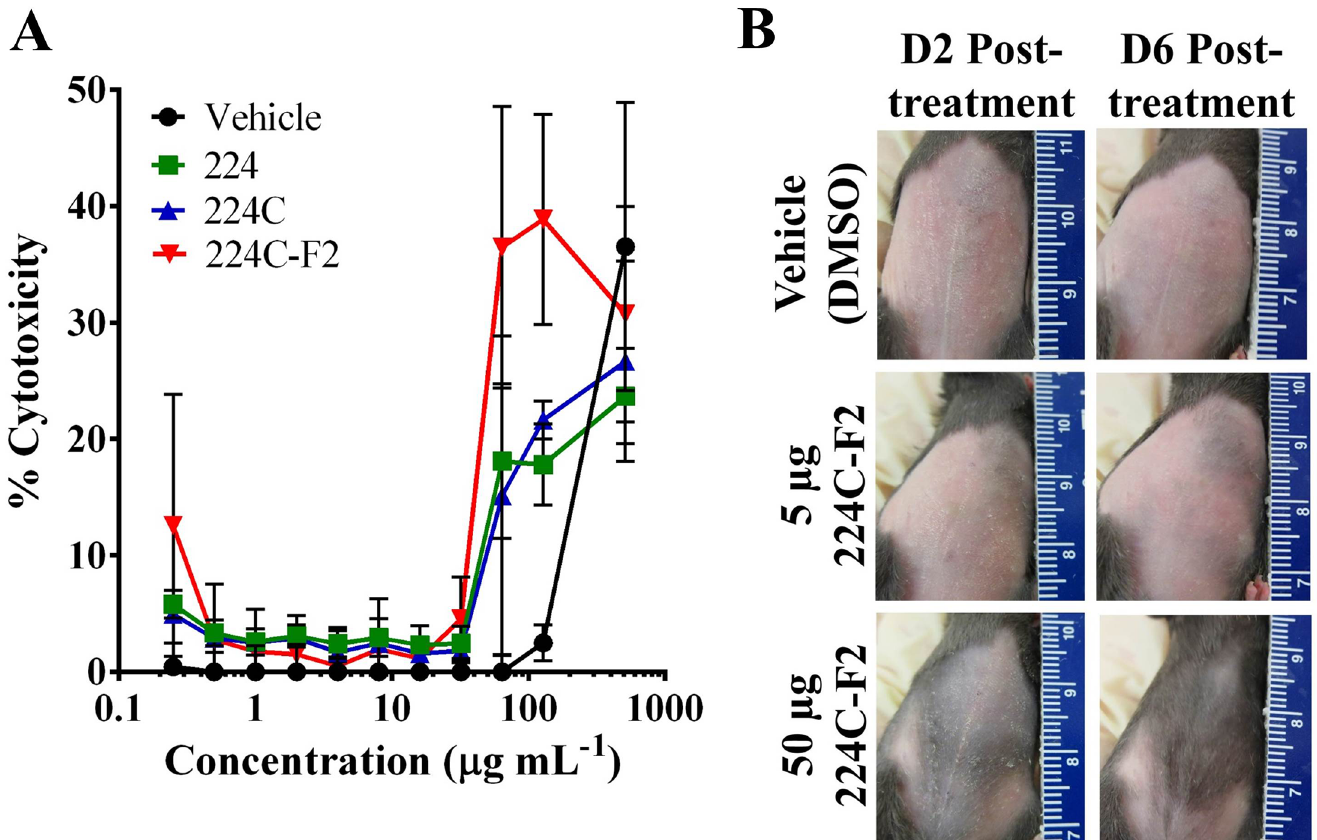
Fig 7. 224C-F2 is non-toxic to human keratinocytes and murine skin. (A) Immortalized human keratinocytes (HaCaT cells) were treated with up to 512 μ g mL -1 of extract fractions (24 hrs). The LD 50 for 224C-F2 could not be determined at this test range, indicating that it is well above the active dose for quorum quenching activity (IC 50 = 1.56 – 25 μ g mL -1 , depending on strain). (B) Uninfected mice received an intradermal injection of 5 or 50 μ g 224C-F2. No gross alterations in skin appearance were